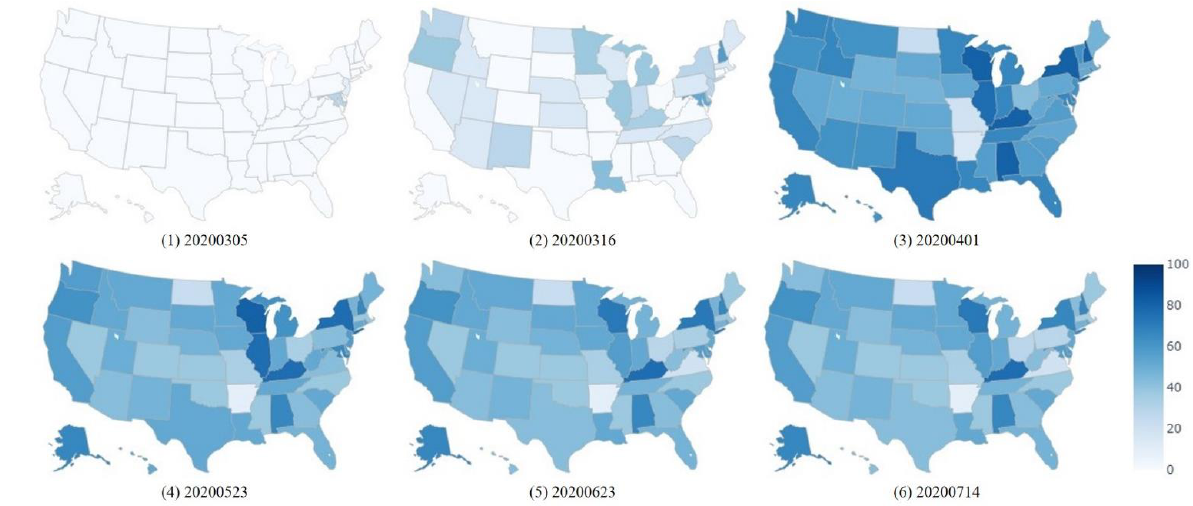
Figure A1. Policy stringency in the US during the epidemic of COVID-19.